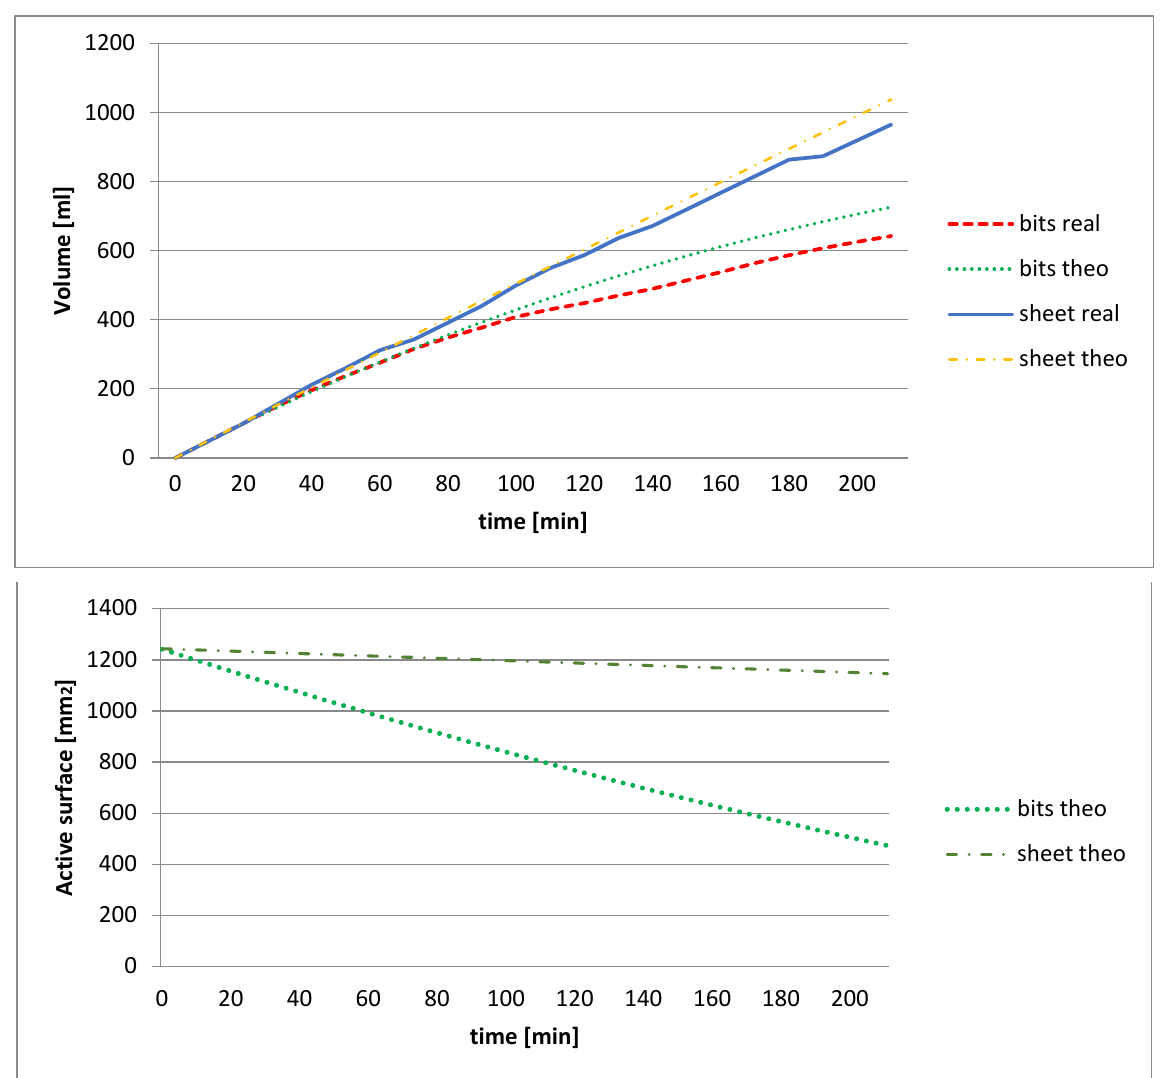
Figure 4. Comparison of the volume of hydrogen generated (in the figure above) from 104 sheet metal chips (chips) and a sheet (sheet), with the similar beginning active surface NaOH solution in a 7.5 M (with isopropyl alcohol), at 25 °C and its theoretical active surface as a function of time (in the figure below).